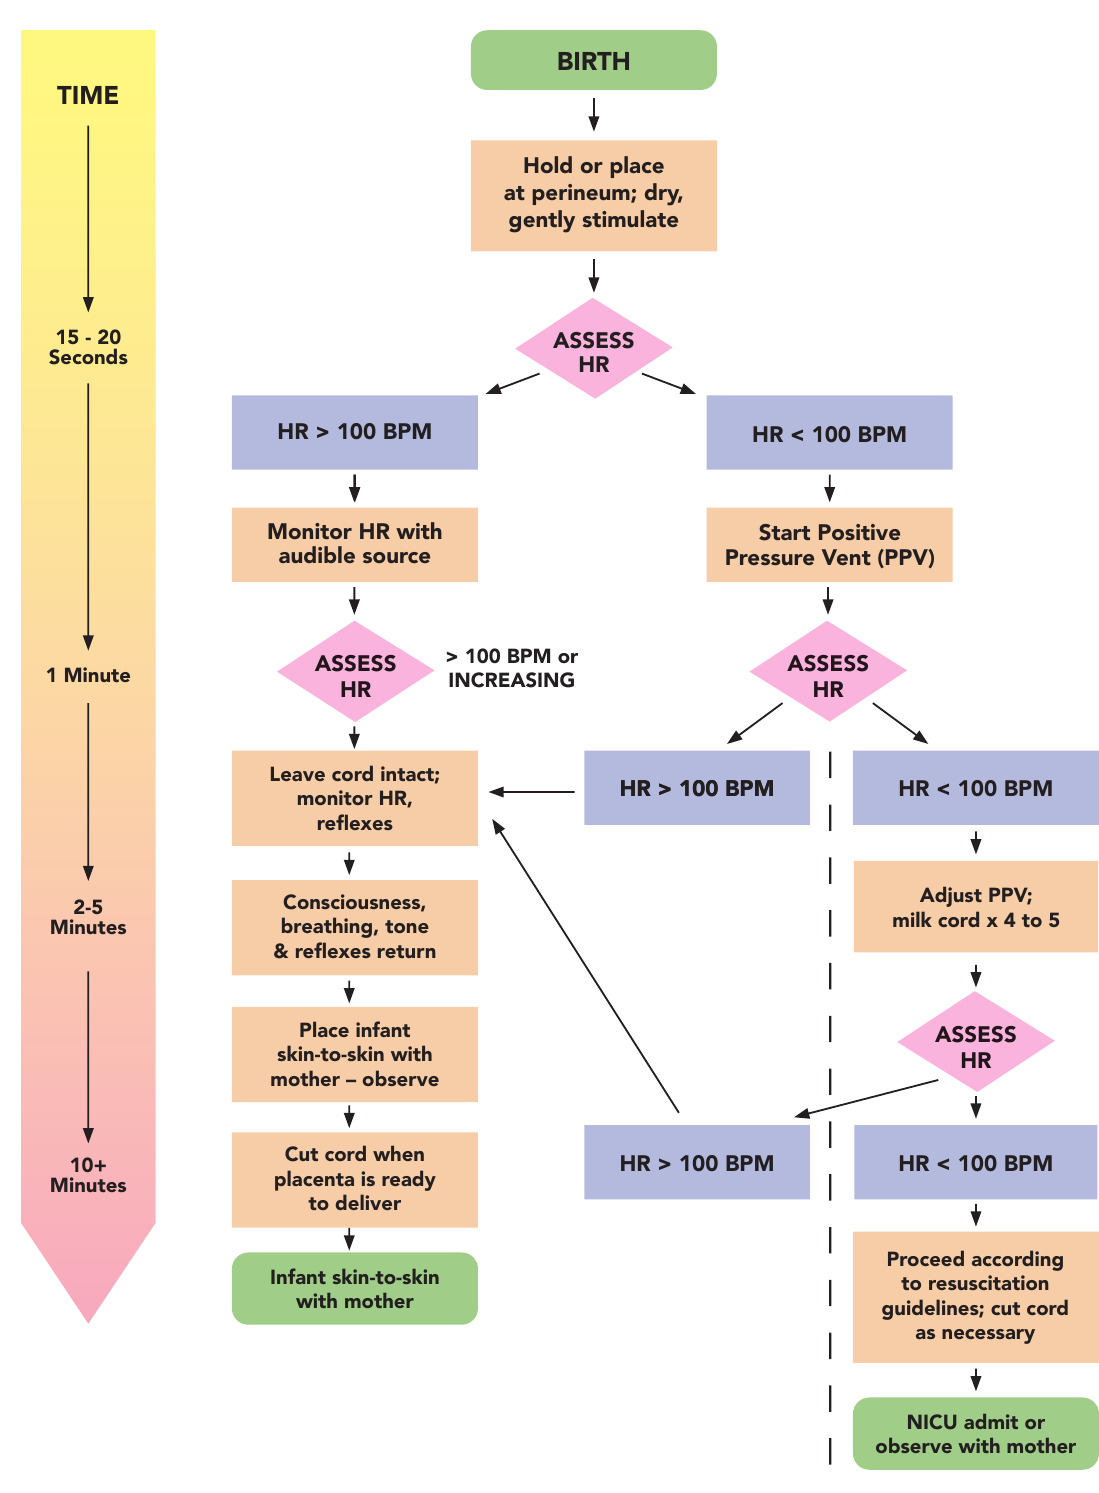
Figure 4. Proposed Algorithm for Resuscitation of Pale, Non-Vigorous Infants at Birth. HR: Heart Rate, BPM: Beats per Minute PPV: Positive Pressure Vent, NICU: Neonatal Intensive Care Unit; Timeline on left does not apply to items on right of the dotted line after 2–5